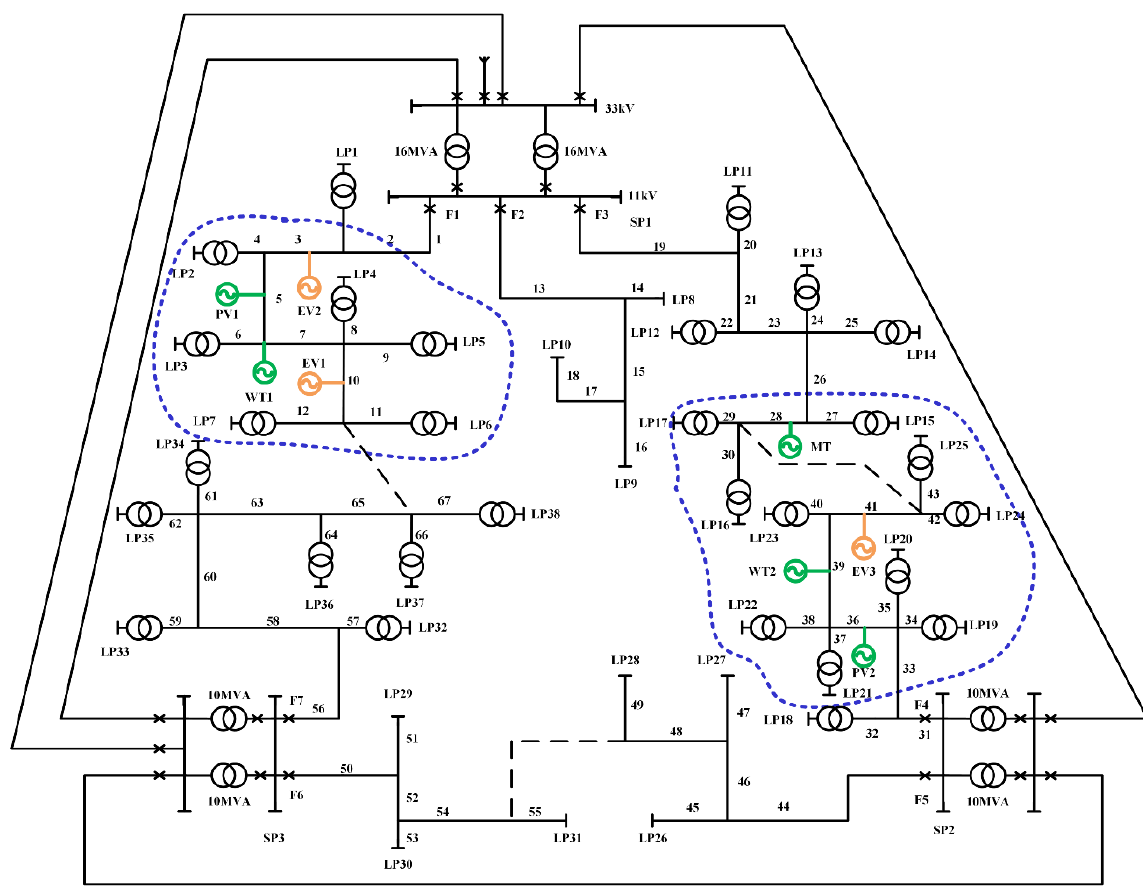
Figure 12. The improved RBTS-Bus 4 test